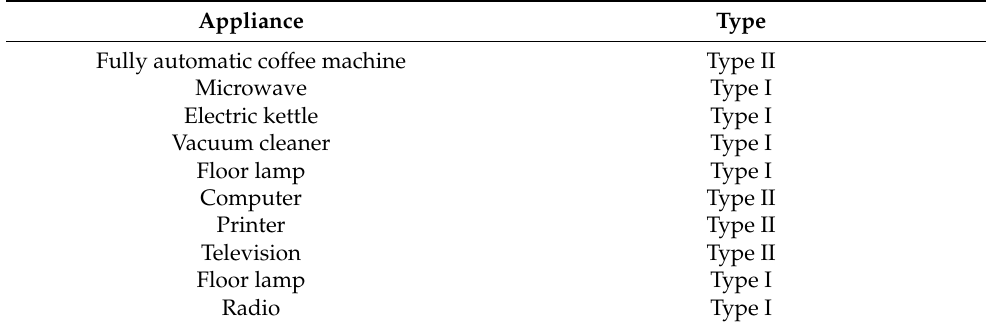
Table 2. Submetered appliances in the household 07 including the assignment of device type.